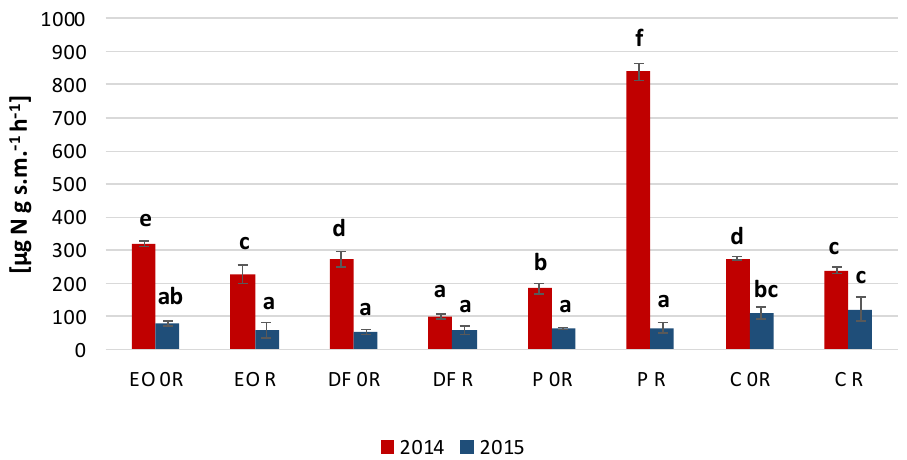
Figure 4. Urease activity after four (2014) and five (2015) years from soil contamination and the use of ZB-01. Mean values marked with the same letters for each year separately do not differ significantly according to the LSD test at p < 0.05. Symbols are the same as those used in Figure 1. Vertical bars show mean ± SE.